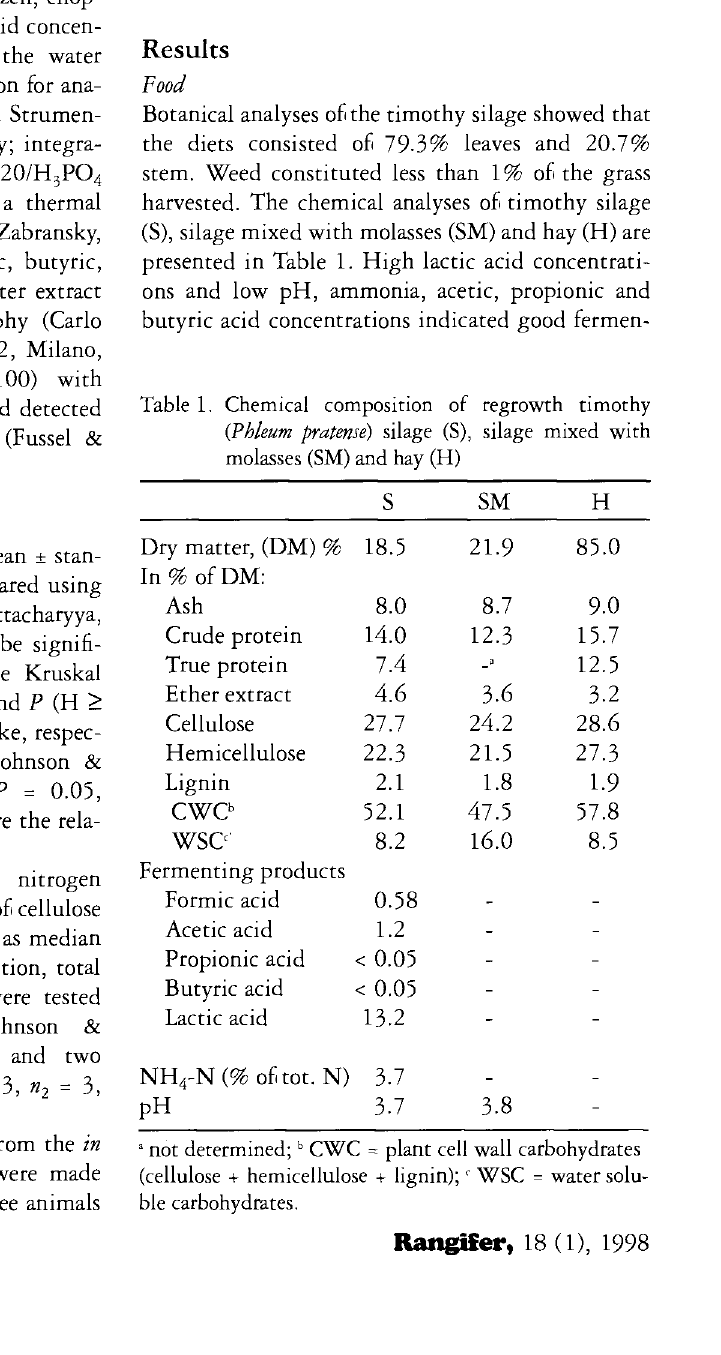
Table 1. Chemical composition of regrowth